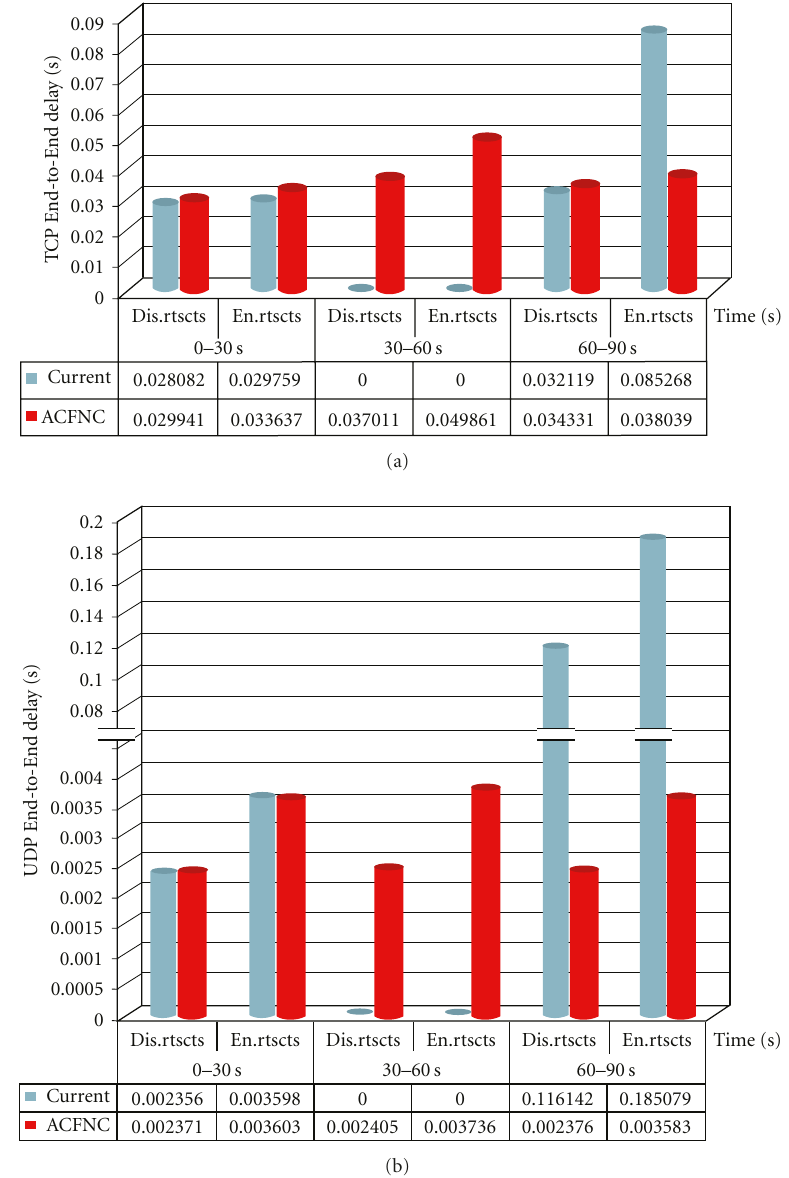
Figure 6: (a) TCP, (b) UDP delay comparison under